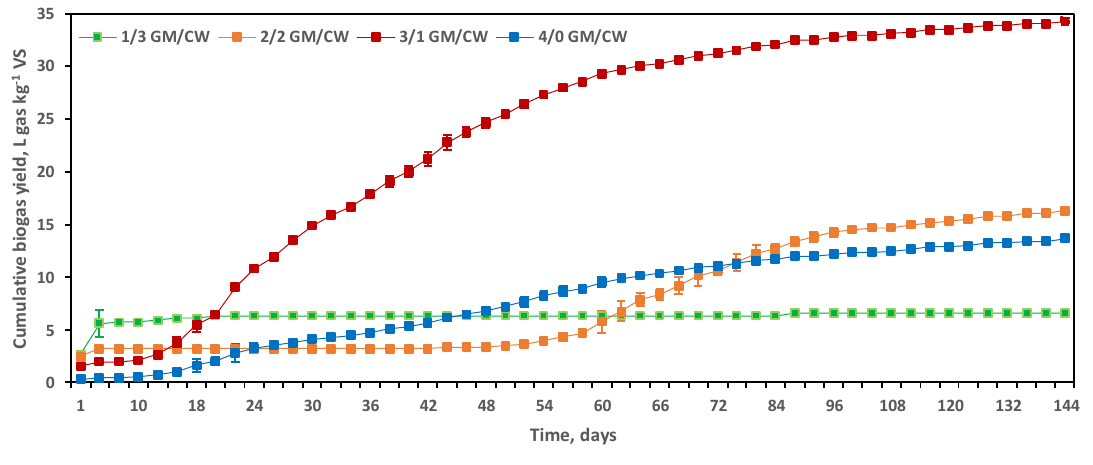
Figure 1. Cumulative biogas yield (L gas kg −1 VS) in dry-thermophilic digesters (55 °C). Triplicate digesters were averaged and reported as mean ± standard error. The separate feedstock mixing ratios were 1/3 GM/CW ( w / w ; green); 2/2 GM/CW ( w / w ; orange); 3/1 GM/CW ( w / w ; red); and 4/0 GM/CW ( w / w ; blue).